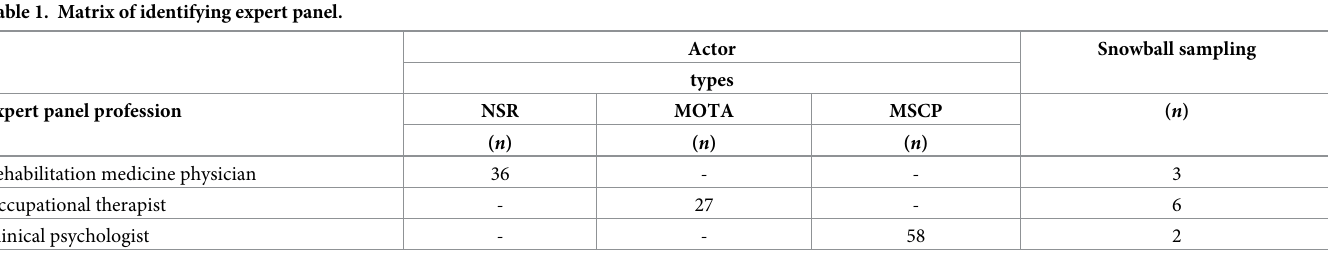
Table 1. Matrix of identifying expert